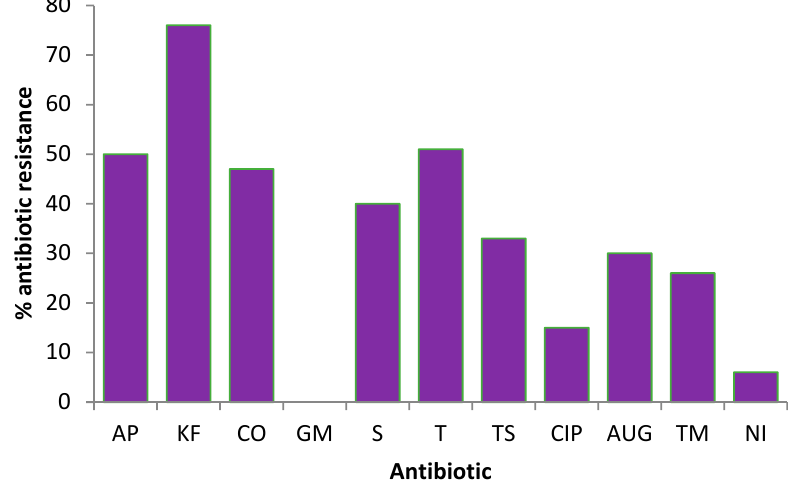
Figure 2. Percentage antibiotic resistance of E. coli isolates to selected antibiotics.